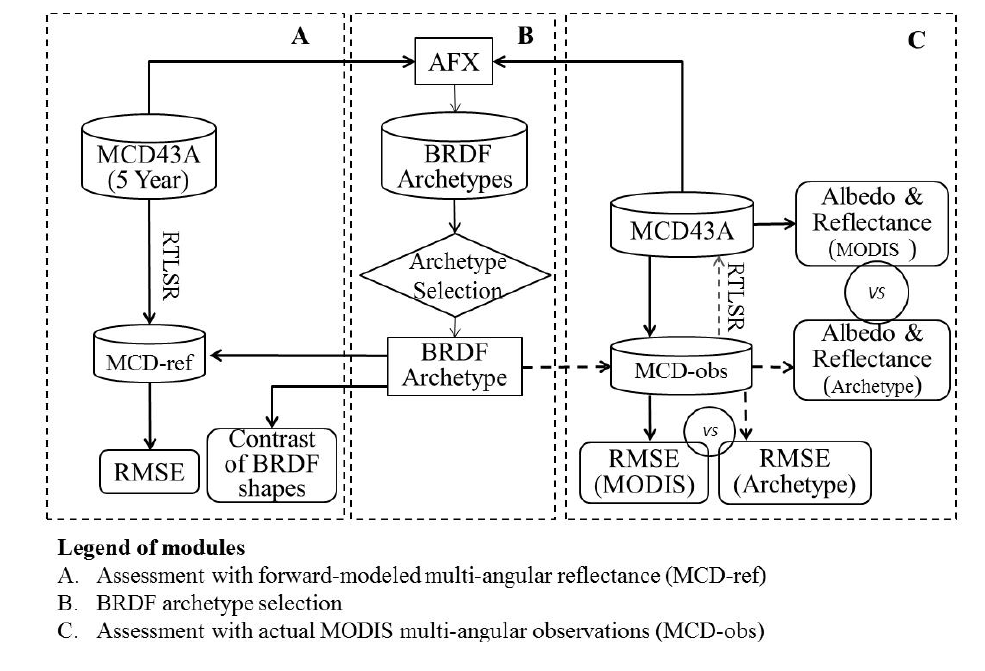
Figure 1. Flowchart for evaluating the representativeness of BRDF archetypes for surface reflectance anisotropy from MODIS